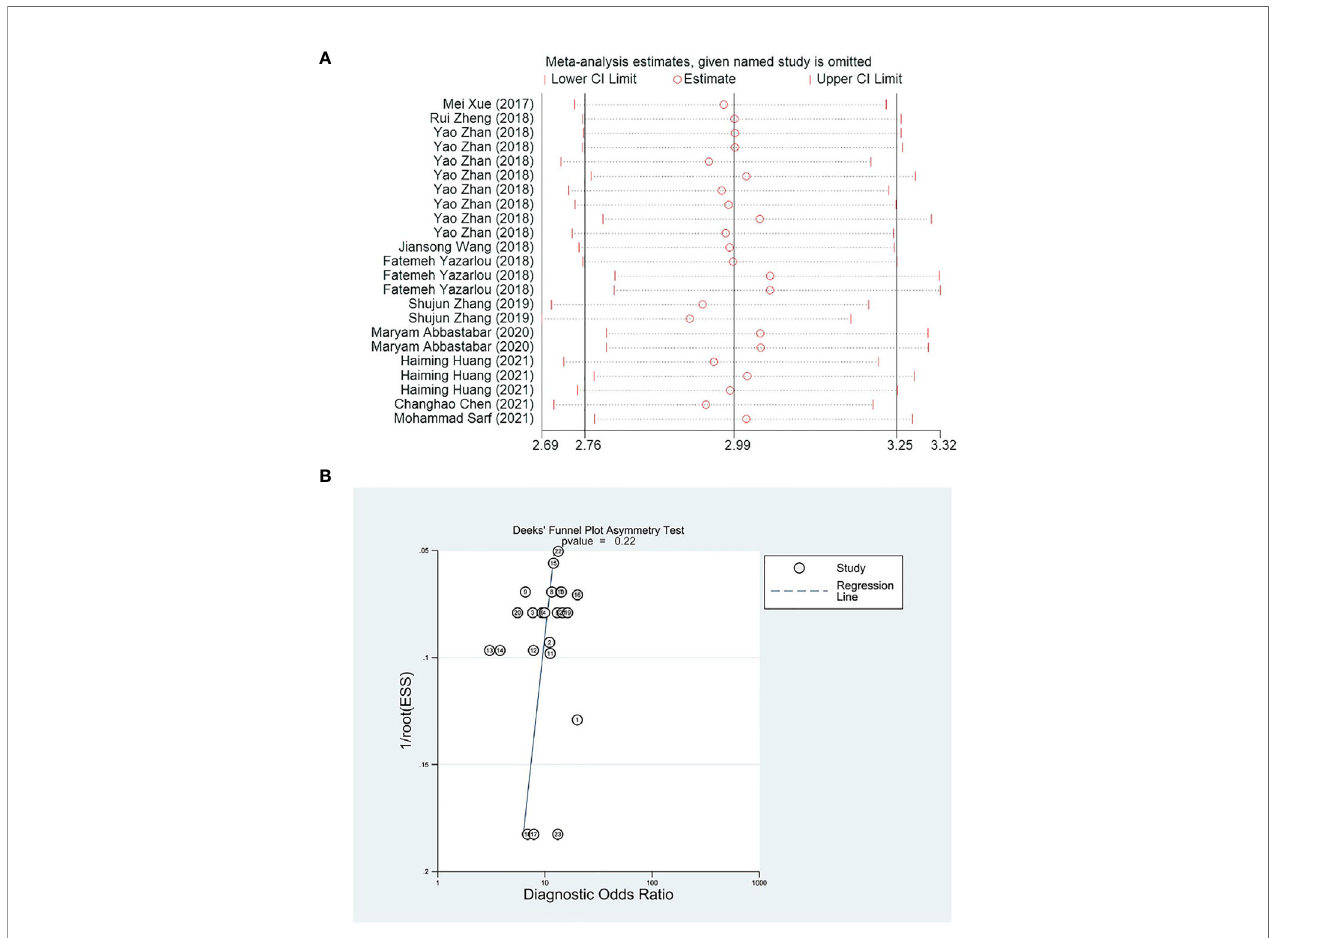
FIGURE 6 | (A) Forest plots of sensitivity analysis. (B) Deeks ’ funnel plot asymmetry